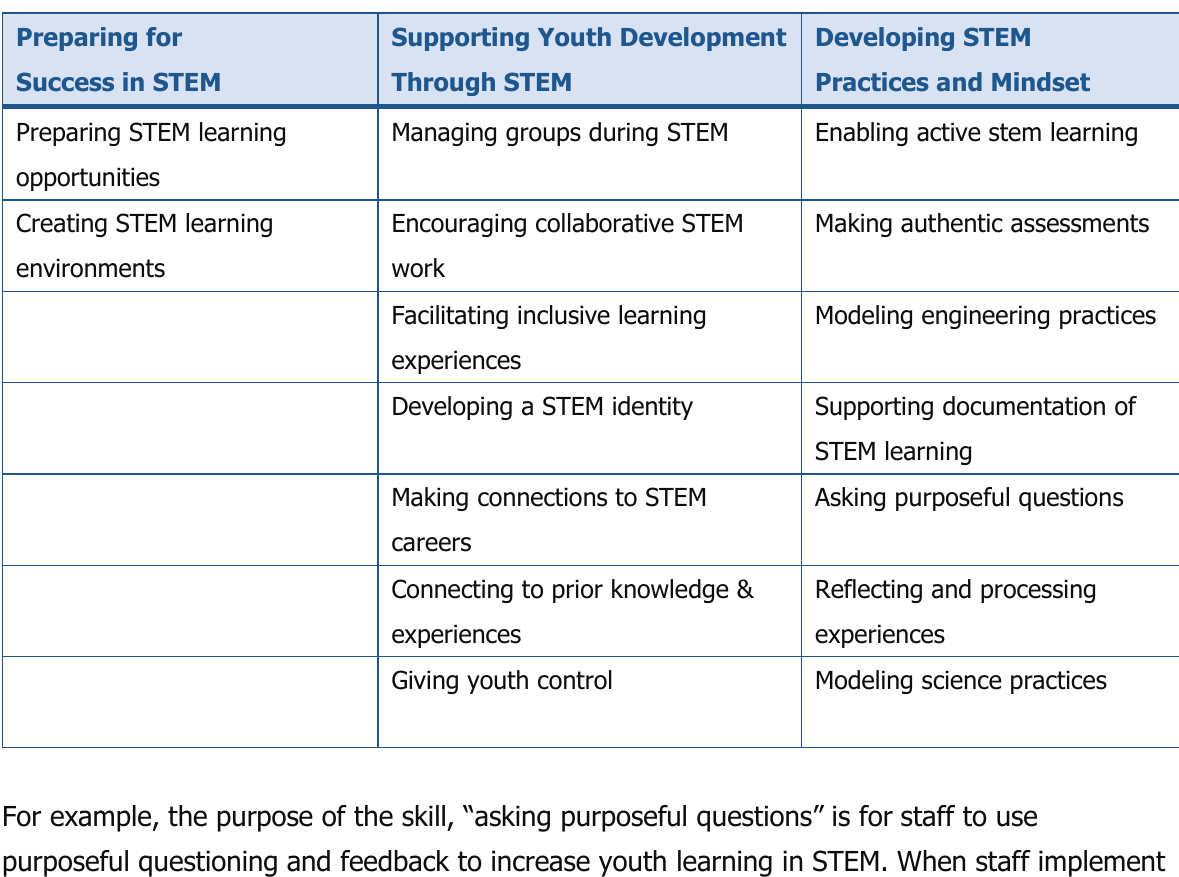
Table 1. The Click2SciencePD Strategies and